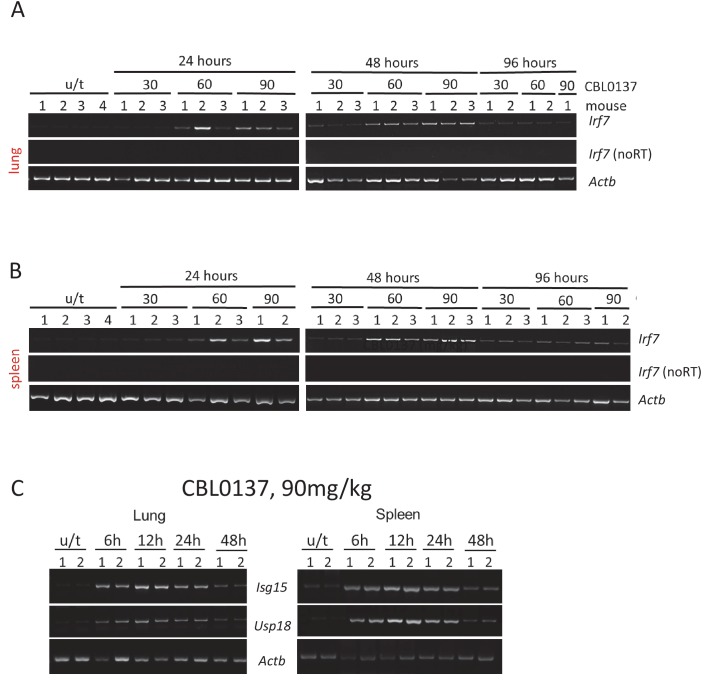
Images of RT-PCR reactions used for quantitation for Figure 3.